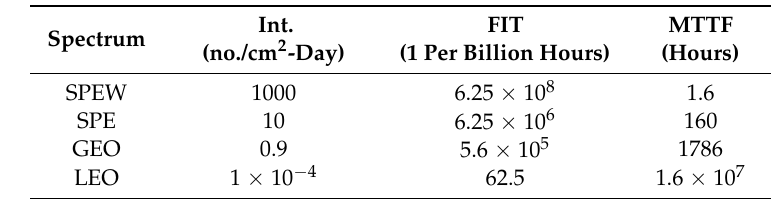
Table 1 tabulates the integral evaluated for LET greater than 10 MeV-cm 2 /mg behind 100 mils of aluminum shielding, the worst-case FIT and the MTTF for the episodic cases considered above and for two additional long-term average environments (GEO, LEO) as calculated using CREME96 [18]. Table 1. Value of integral LET spectra (Int.) and SiC MOSFET FIT and MTTF for several space scenarios. All results assume 100 mils of aluminum shielding.